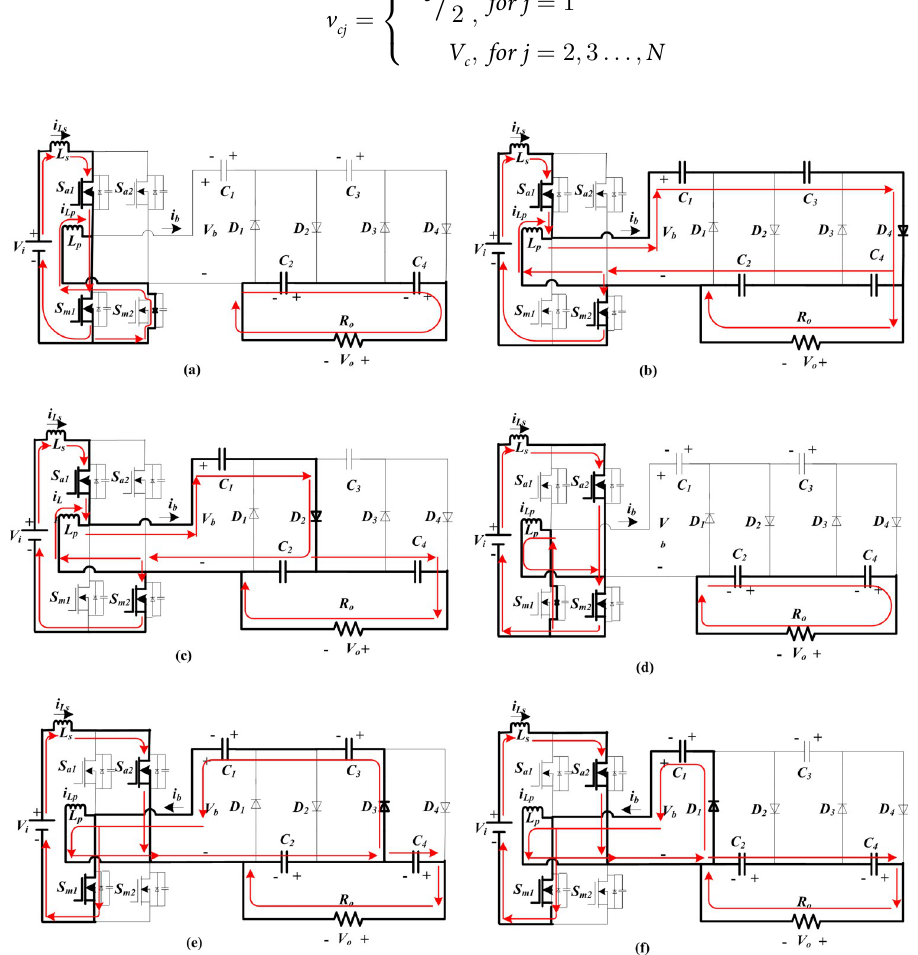
Fig 3. Operating stages of the proposed